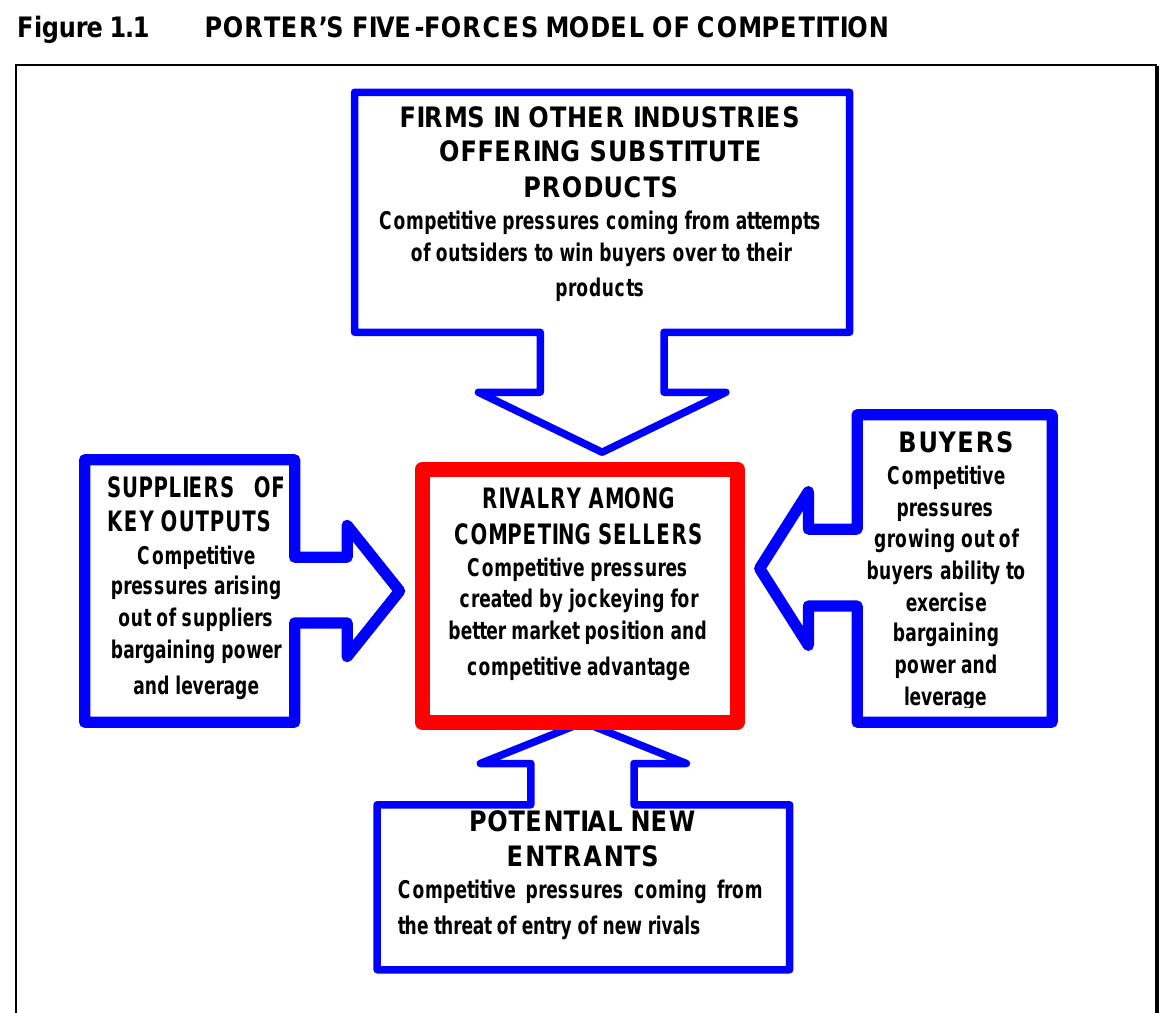
Figure 1.1 PORTER’S FIVE-FORCES MODEL OF